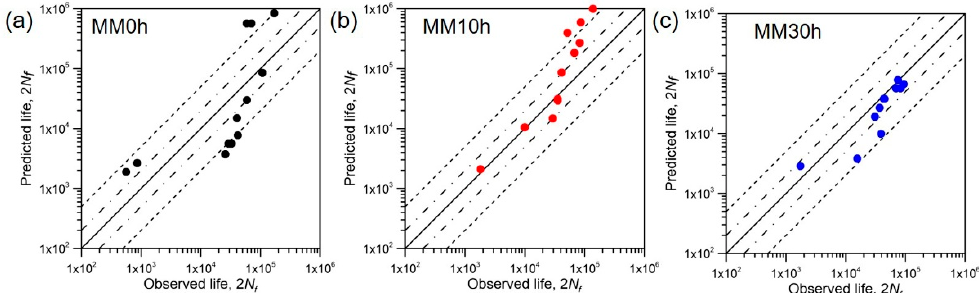
Figure 9. Comparison between observed life and predicted life based on the modified SWT fatigue-life-prediction model of harmonic-structured SUS316L steels: ( a ) MM0h compacts; ( b ) MM10h compacts; ( c ) MM30h compacts.